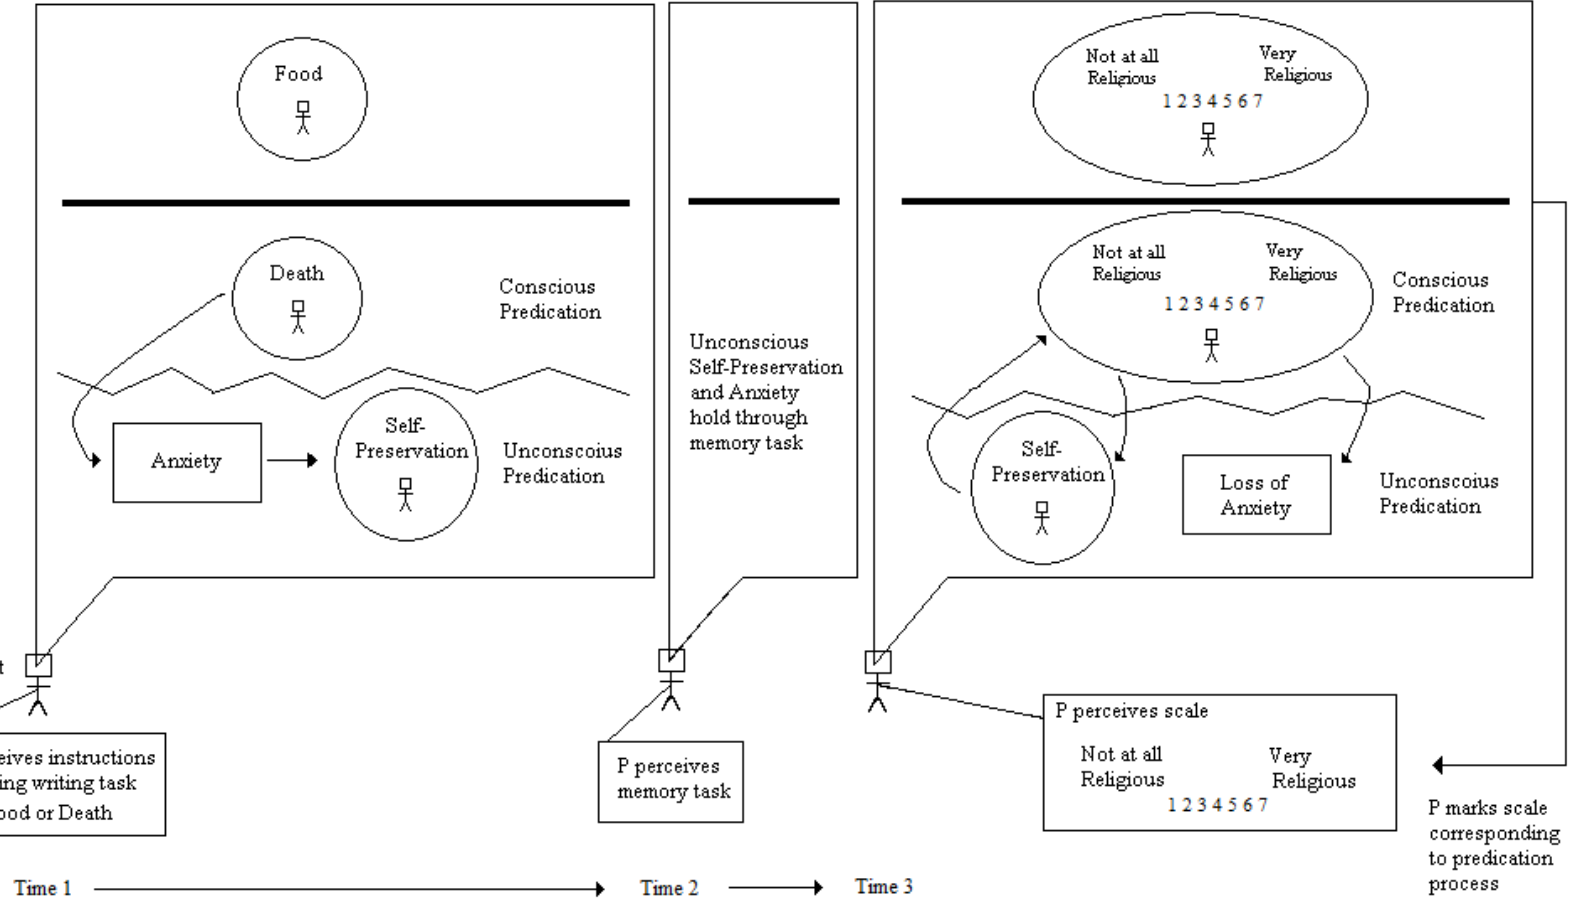
Figure 10. Integrated model for study of Terror Management